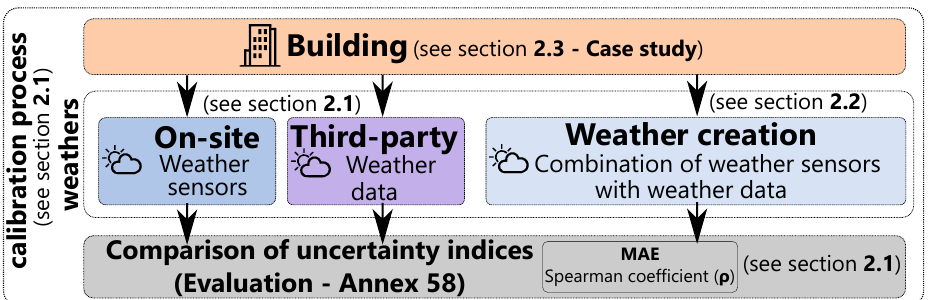
Figure 1. Diagram of the developed